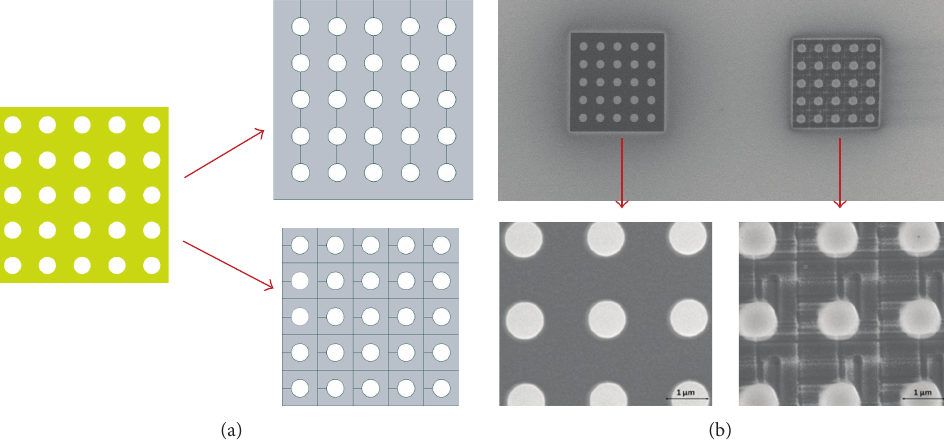
Figure 3: Patterns with unconventional shapes are converted into filled polygons in the GDS description, which can be done in various ways (a). Not only it is important how patterns are defined by patterning objects, but also how those objects are scanned according to the filling algorithm applied. SEM images in (b) show apparently different pattern quality when islands are created using different approaches to fill the space around them (other parameters are the same: 30 kV, 57 pA Ga ions, 1 𝜇 s dwell time, 22 nm dwell distance, 500 repetition). The pattern on the right was processed by an e-beam lithography software connected to drive the ion beam, while the pattern on the left was filled by line scans that run intermittently along the whole width of the pattern. The sample material is single crystal silicon with native oxide on the